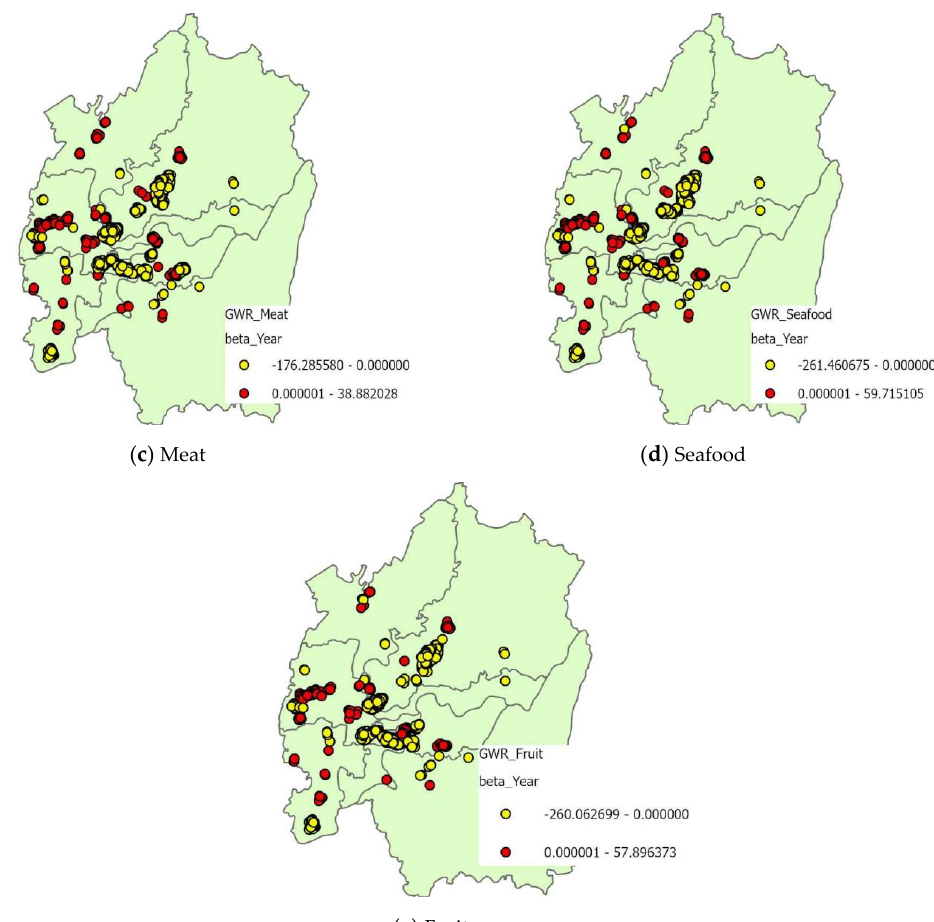
Figure 13. House building year coeffects with the accessibility values of grains, oils, and eggs; vegetables; fruits; seafood; and meat in Chongqing.